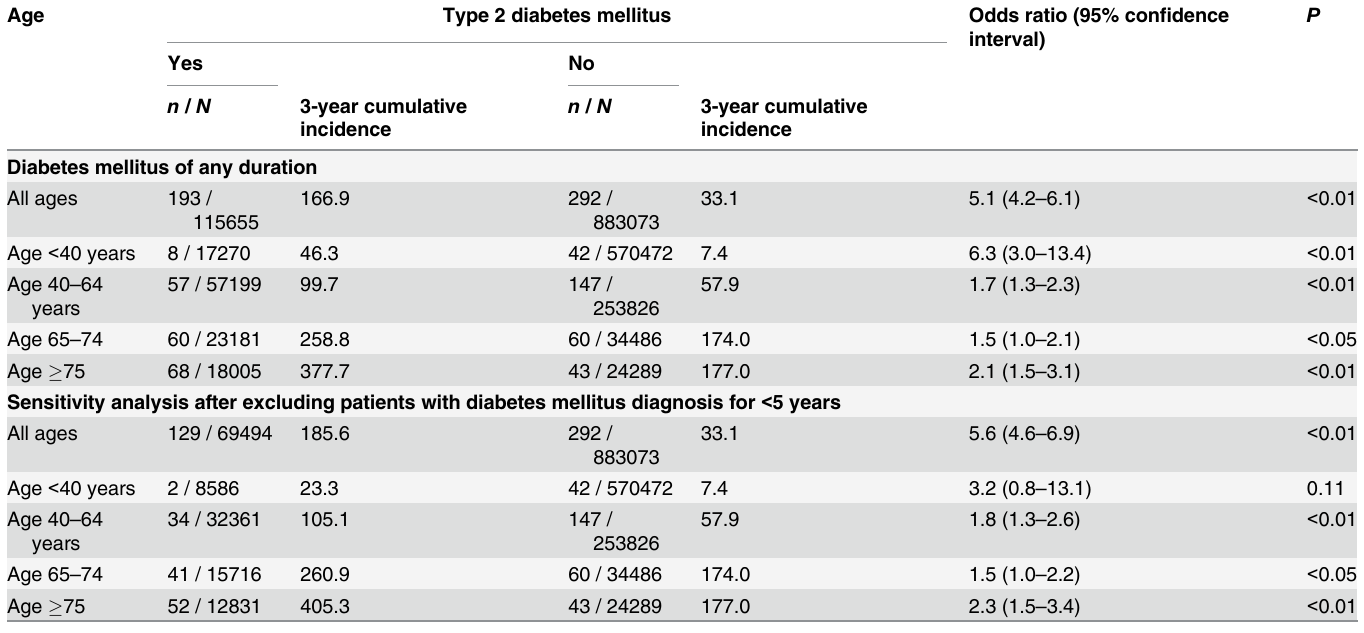
Table 2. Cumulative incidence (per 100,000) of kidney cancer from 2003 to 2005 in diabetic patients and non-diabetic people by age and the unad- justed odds ratios comparing diabetic patients to non-diabetic people.